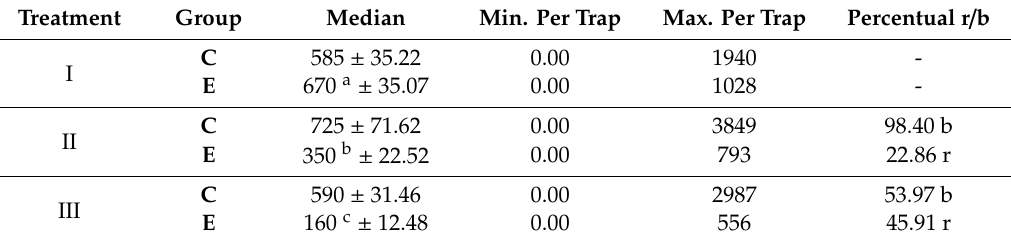
Table 5. Number of Alphitobius diaperinus per trap depends on the treatment (n = 60) . Treatment Group Median Min. Per Trap Max. Per Trap Percentual r / b C 585 ± 35.22 0.00 1940 I